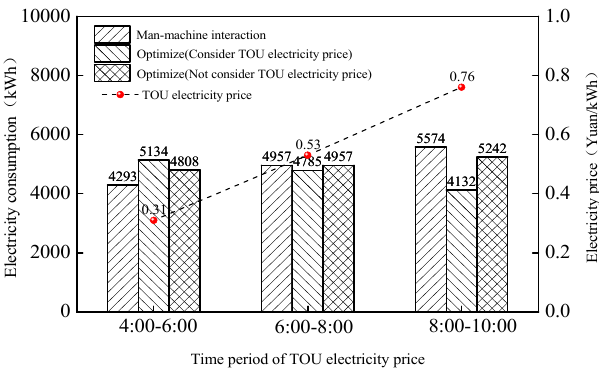
Figure 13. Electricity consumptions at different time periods.